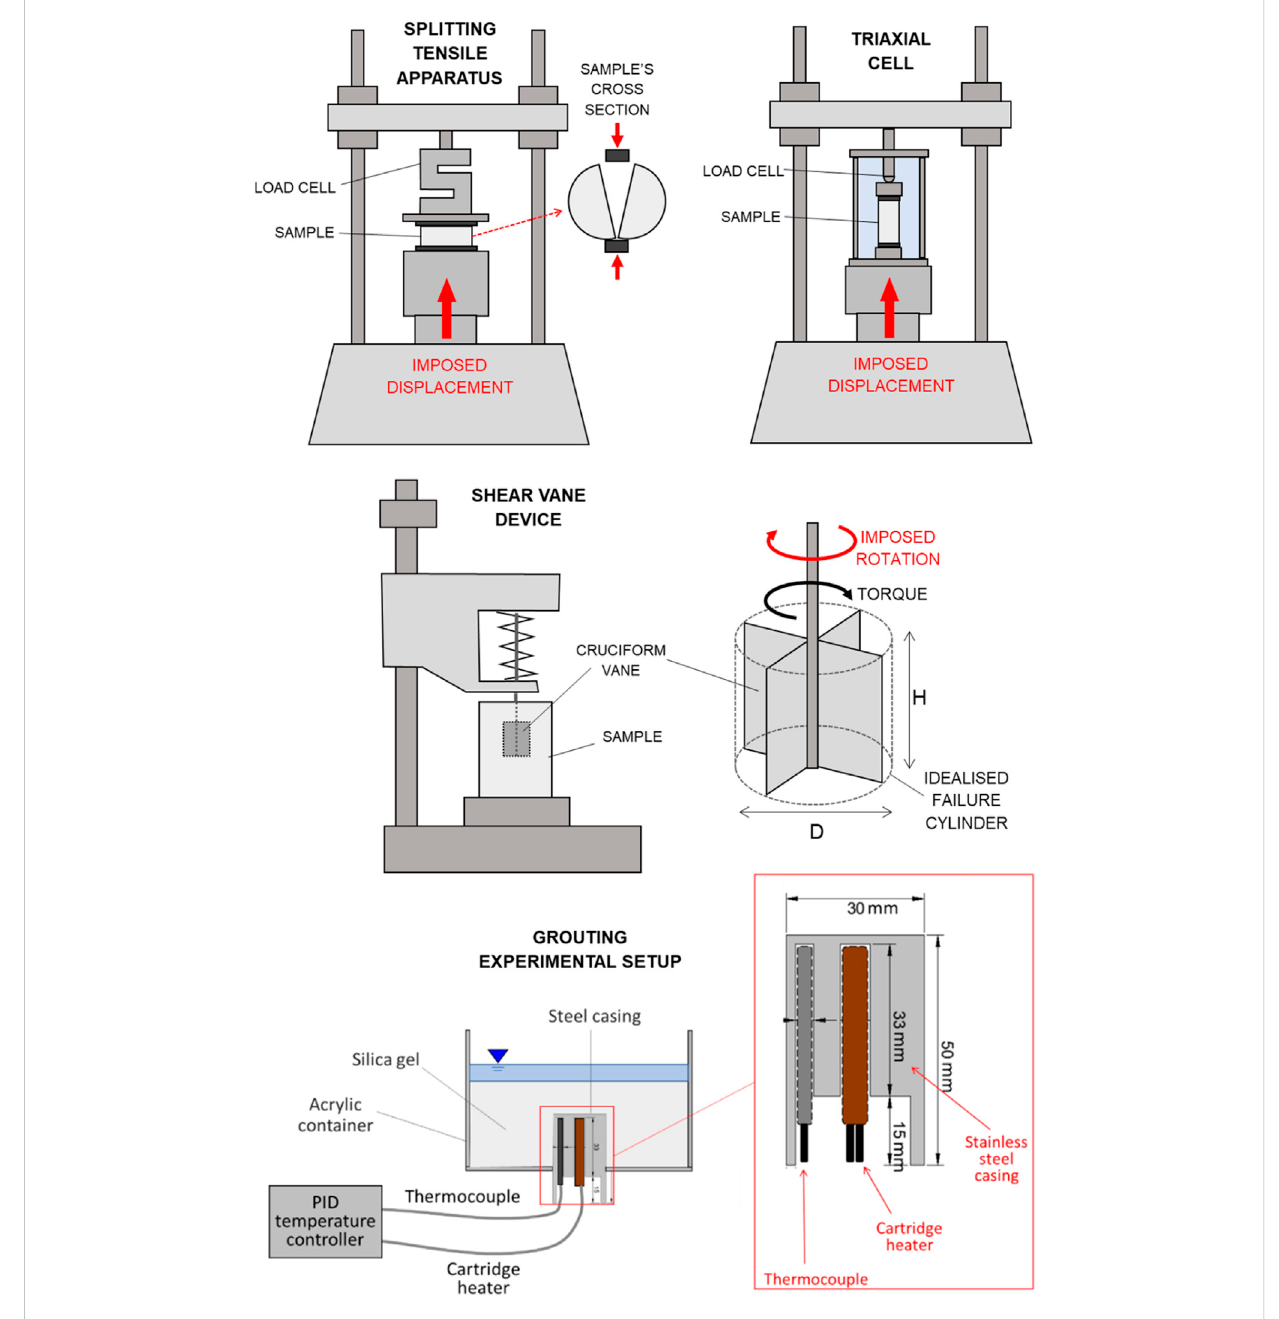
FIGURE 2 Schematic view of the experimental setups for splitting tensile testing, triaxial testing, shear vane testing, and grouting experiments.